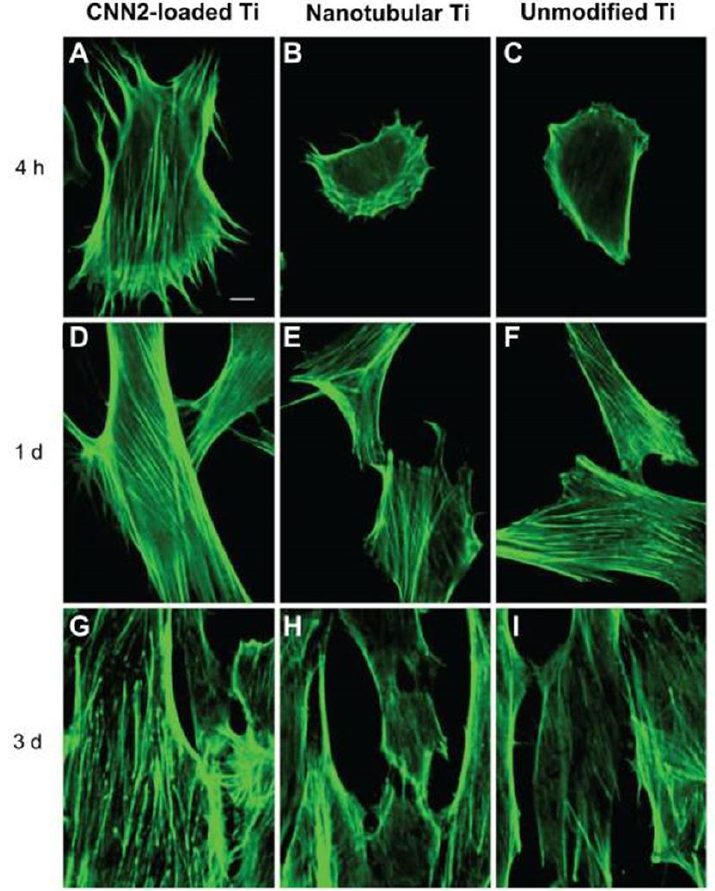
Figure 8. Protein-releasing nanotubular implants towards soft-tissue integration. Confocal imag- ing of interaction of human skin fibroblasts on CNN2-loaded, nanotubular and bare Ti implants. ( A – C ) Cell morphology was more stretched with additional stress fibers on CCN2-loaded nanotubes at 4 h. ( D – I ) Higher amount of intracellular contacts with confluent stress fibers were observed on CCN2-loaded nanotubes. Reproduced with permission from